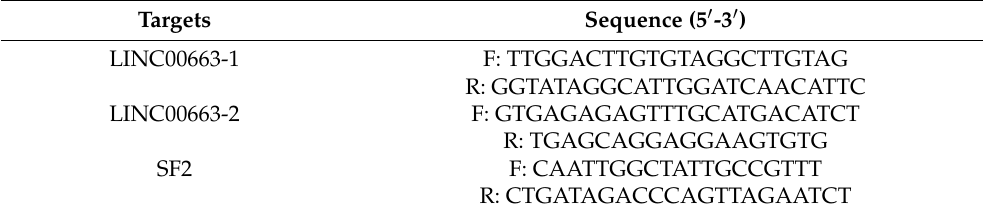
Table 2. Forward and reverse primers for RIP real-time